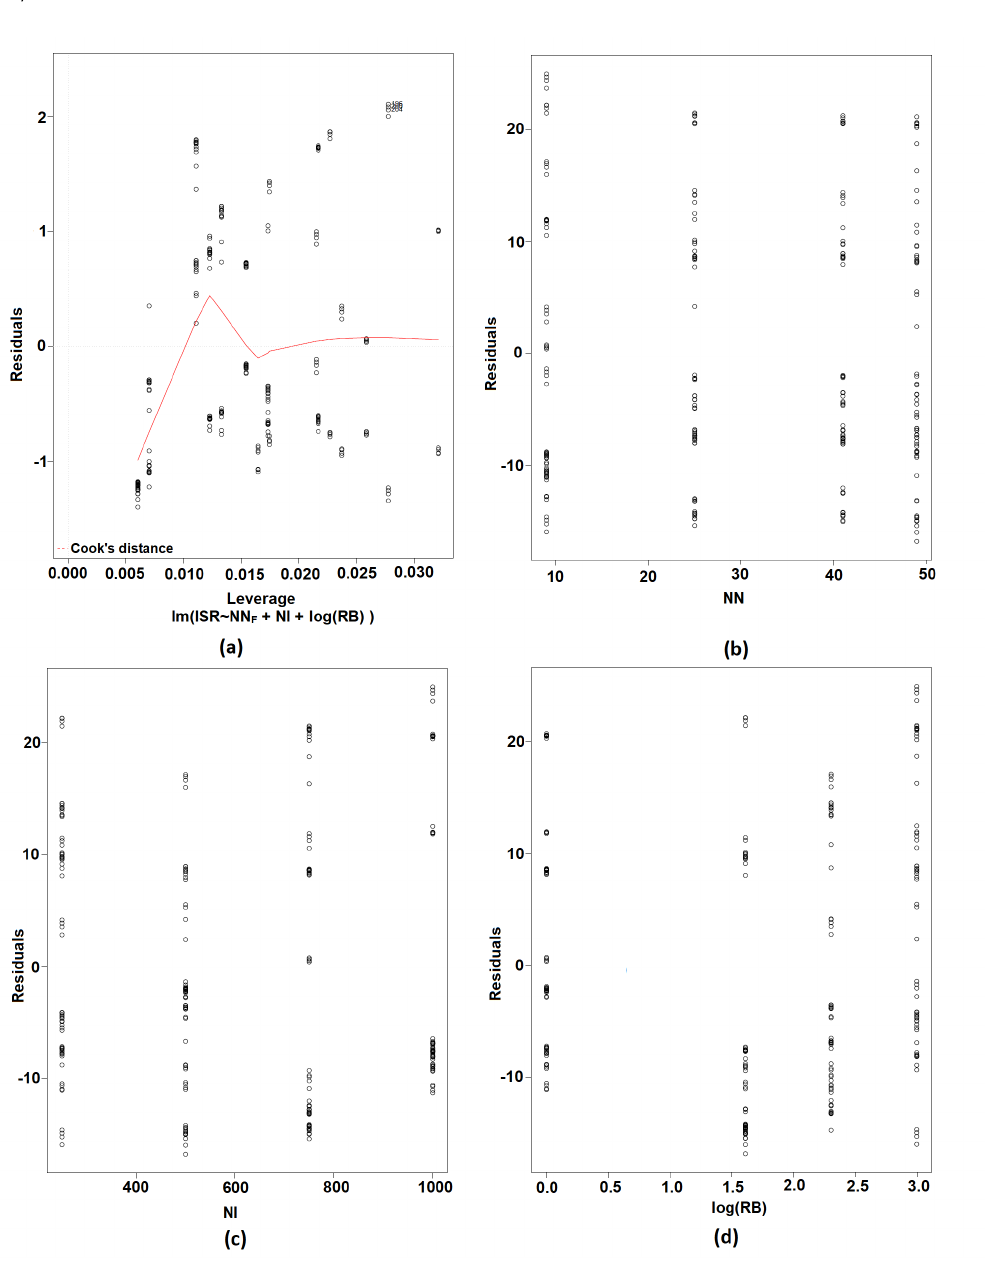
Figure 6. Residuals plots: ( a ) residuals vs. leverage, ( b ) NN residuals, ( c ) NI residuals, and ( d ) log(RB)